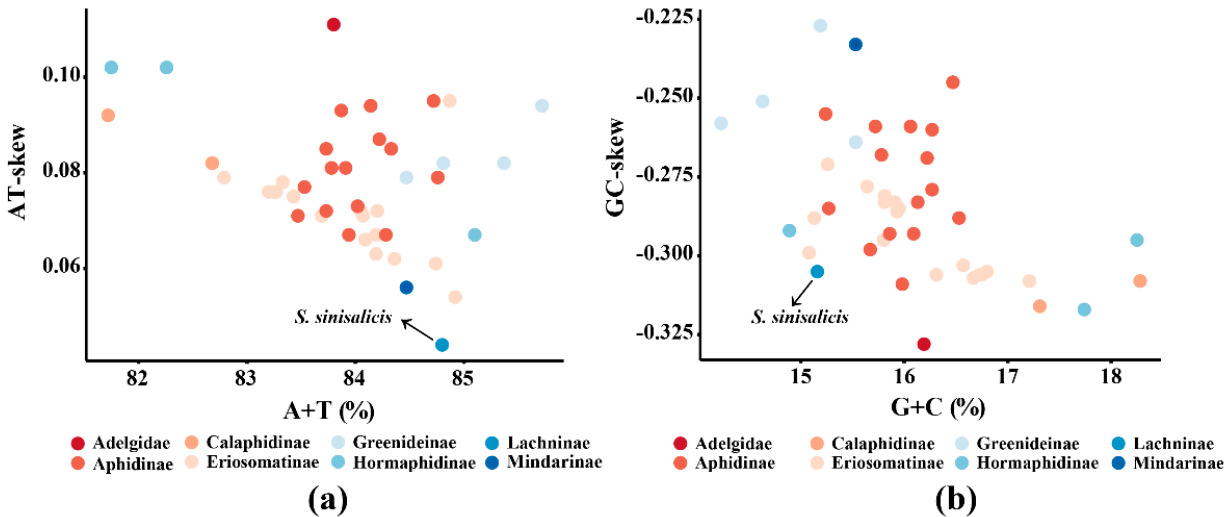
Figure 3. Nucleotide composition of Stomaphis sinisalicis and 44 others complete aphid mitogenomes (including the Adelges tsugae ). ( a ) The A+T content and AT skew. ( b ) The G+C content and GC-skew. See Table S1 for details of aphid species.